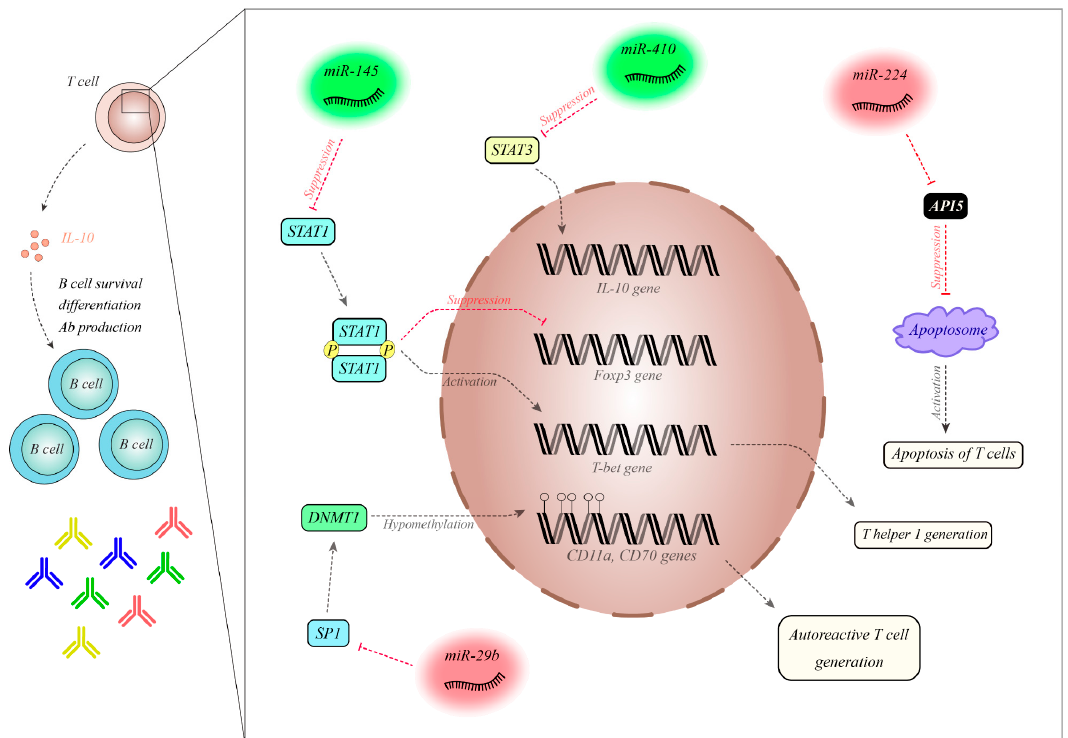
Figure 2. MiR-145 is decreased in SLE patients. MiR-145 has a role in the inhibition of STAT1, which is involved in the di ff erentiation of Treg cells via its inhibition of Foxp3. Moreover, STAT1 induces T-bet, which participates in the di ff erentiation of Th1 cells [36]. MiR-410 is downregulated in SLE patients and is a suppressor of STAT3. STAT3 is an inducer of IL-10. The levels of this cytokine are increased in SLE patients, leading to the enhanced survival and di ff erentiation of B cells and the increased production of antibodies [37]. MiR-224 is increased in SLE patients and has been shown to inhibit API5. API5 decreases the expression of APAF1 and precludes the activation of caspases, thereby hampering apoptosome formation. Thus, the over-expression of miR-224 leads to increased T cell activation-induced cell death. [36]. MiR-29a is upregulated in SLE patients and suppresses Sp1, which is an inducer of ANMT1. The over-expression of miR-29a leads to hypomethylation of CD11a and CD70, which are involved in the production of autoreactive T cells [38] Abbreviations: Treg cell: Regulatory T cell, DNMT1: DNA (cytosine-5)-methyltransferase 1, SP1: specificity protein